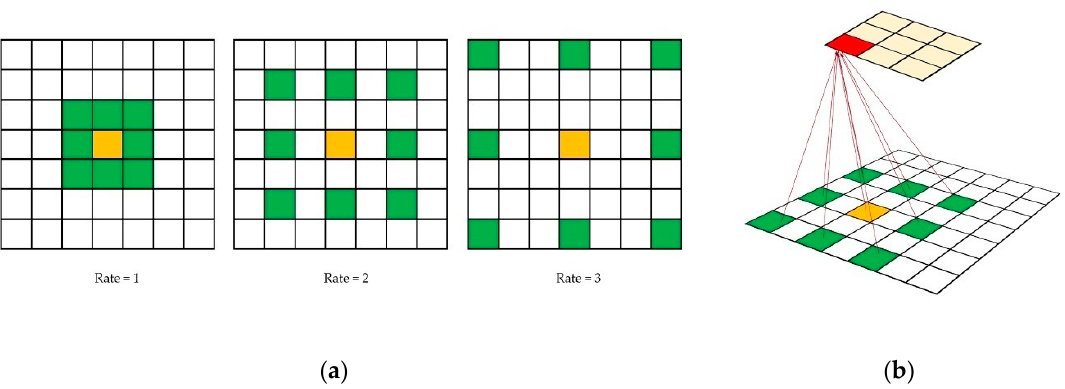
Figure 2. ( a ) Dilated convolutions. ( b ) A dilation rate of one is normal (vanilla) convolution.